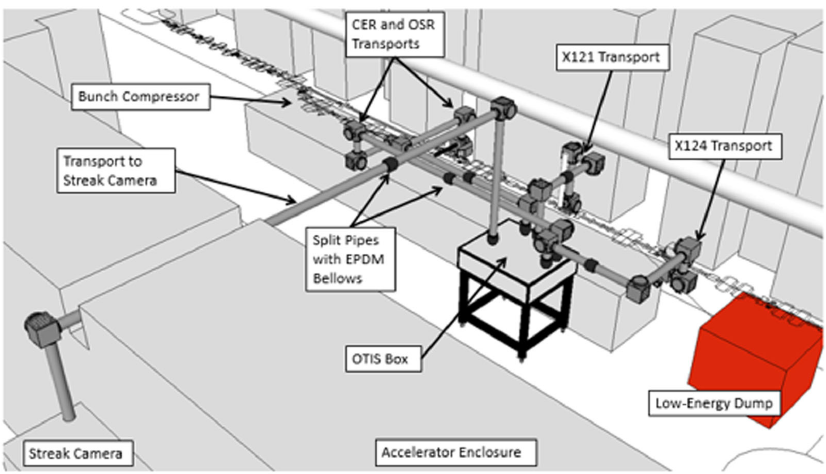
FIG. 3. Schematic of the all-mirror optics transport lines from the X121 station to the streak-camera enclosure outside of the shielding walls